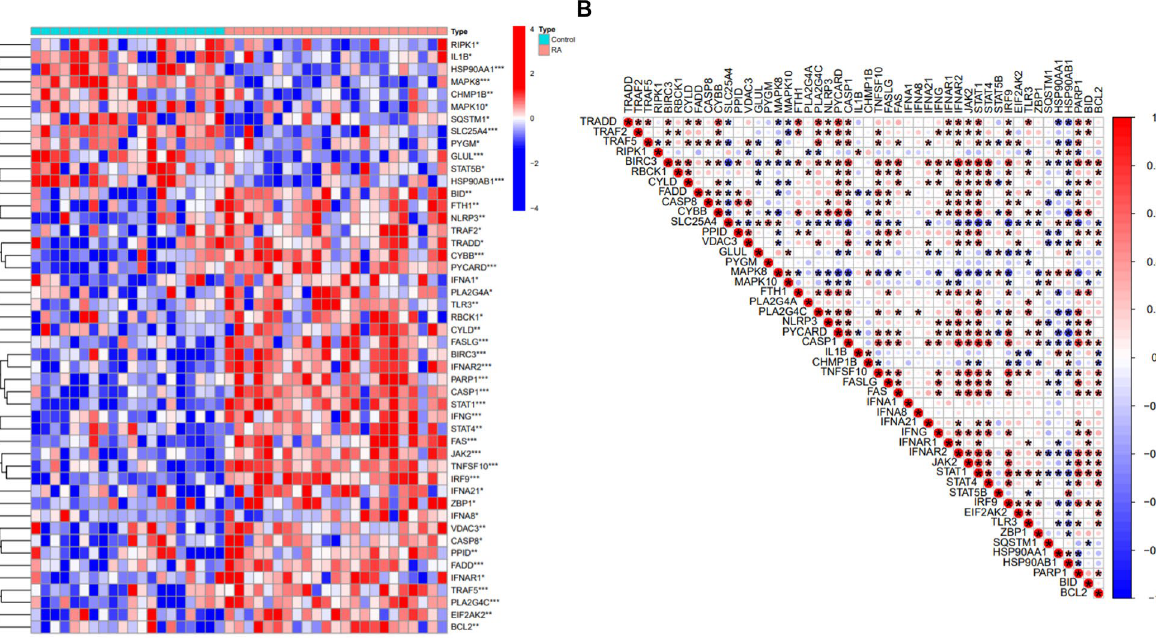
Figure 1. Analysis of expression levels of Necroptosis-related differential genes in RA. ( A ) Heat map showing the expression pattern of NRDEGs in different samples. ( B ) Correlation between the